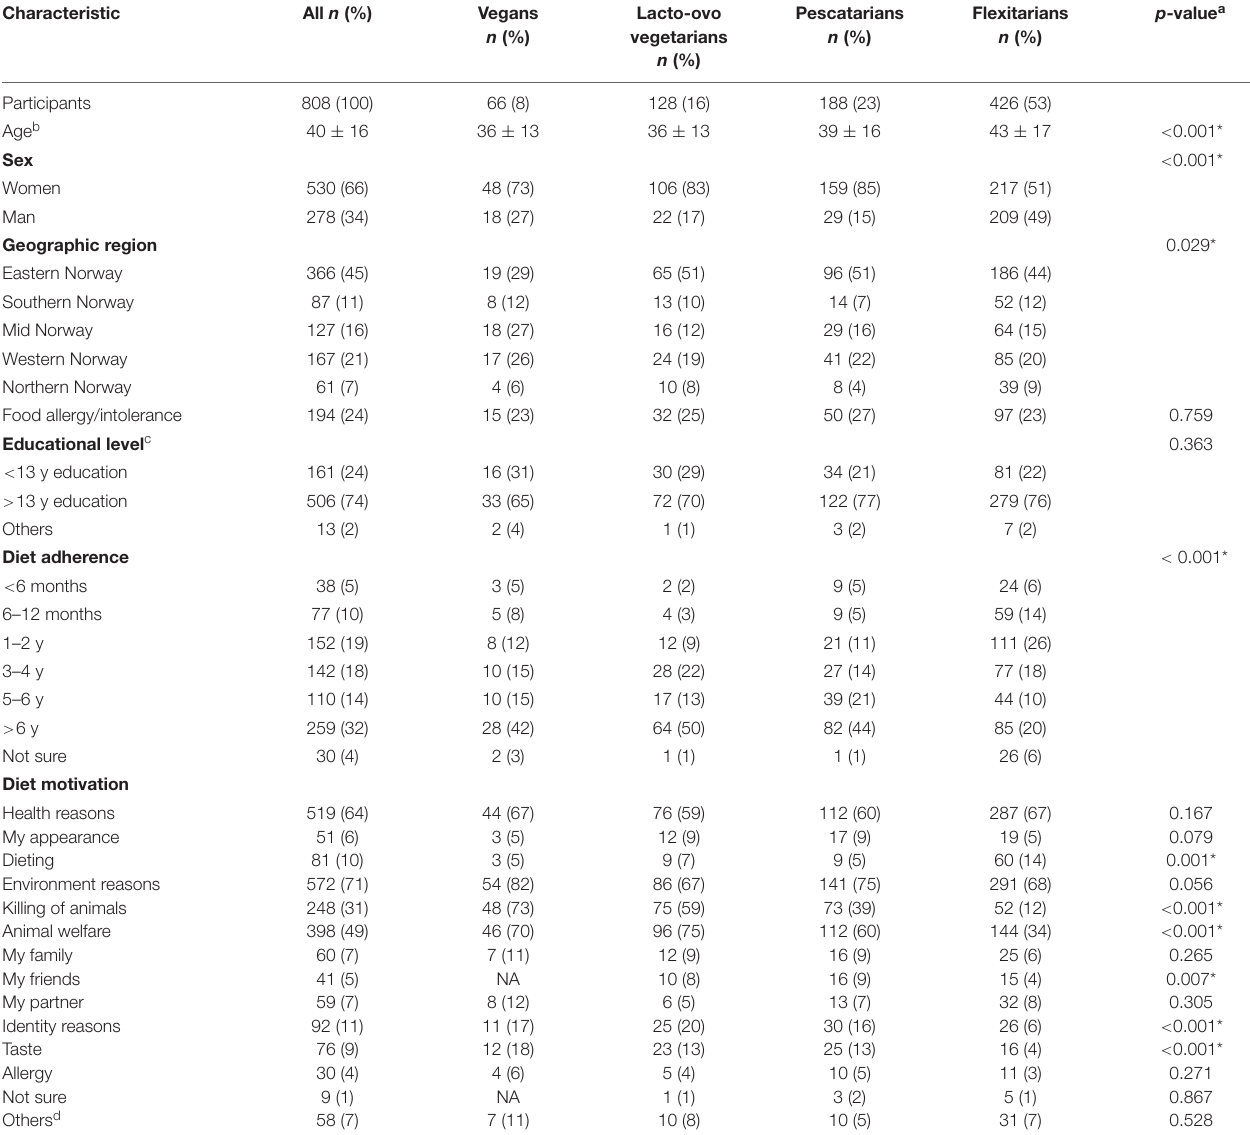
TABLE 1 | Characteristics of participating adult vegans, lacto-ovo vegetarians, pescatarians, and flexitarians in Norway ( n = 808). Characteristic All n (%) Vegans